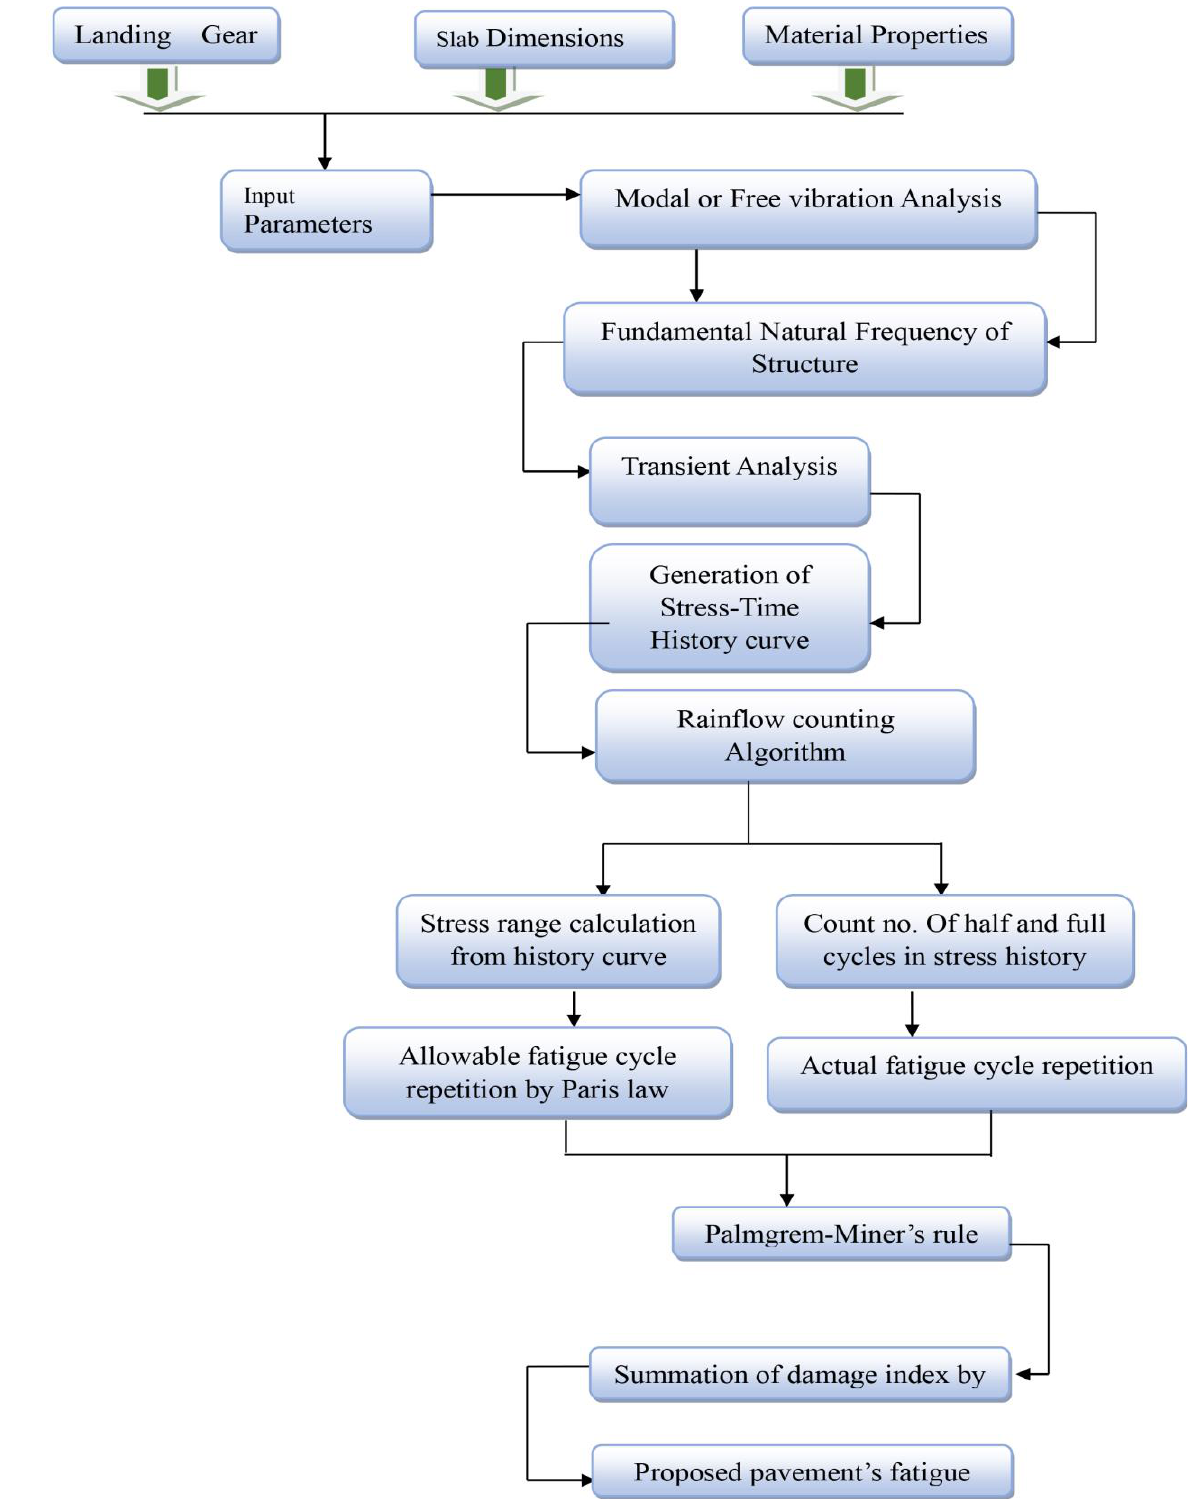
Fig.15. Fatigue life of proposed runway using dynamic